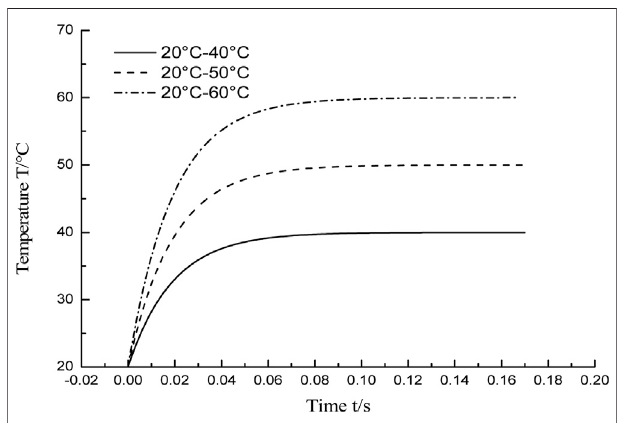
FIGURE 7 | Hysteresis curve of MR damper. FIGURE 6 | Internal temperature simulation curve of MR